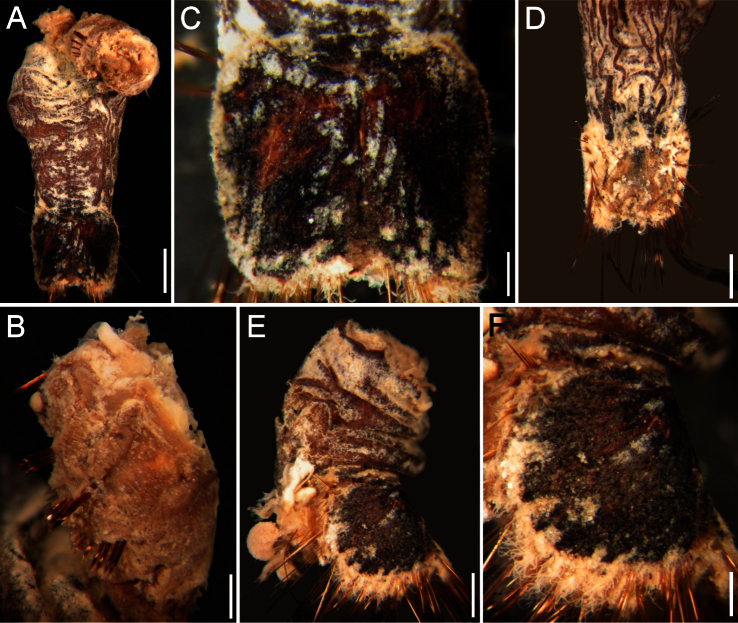
Petersenaspis sp (ZMA 1717) A Complete specimen, ventral view B Same, anterior segments in lateral view C Same, ventro-caudal shield, frontal view, lateral plates forced dorsally D Same, posterior region, dorsal view E Incomplete specimen, lateral view F Same, enlargement of right lateral shield plate. Bars: A 1.2 mm B 0.44 mm C 0.38 mm D 1 mm E 0.9 mm F 0.42 mm.